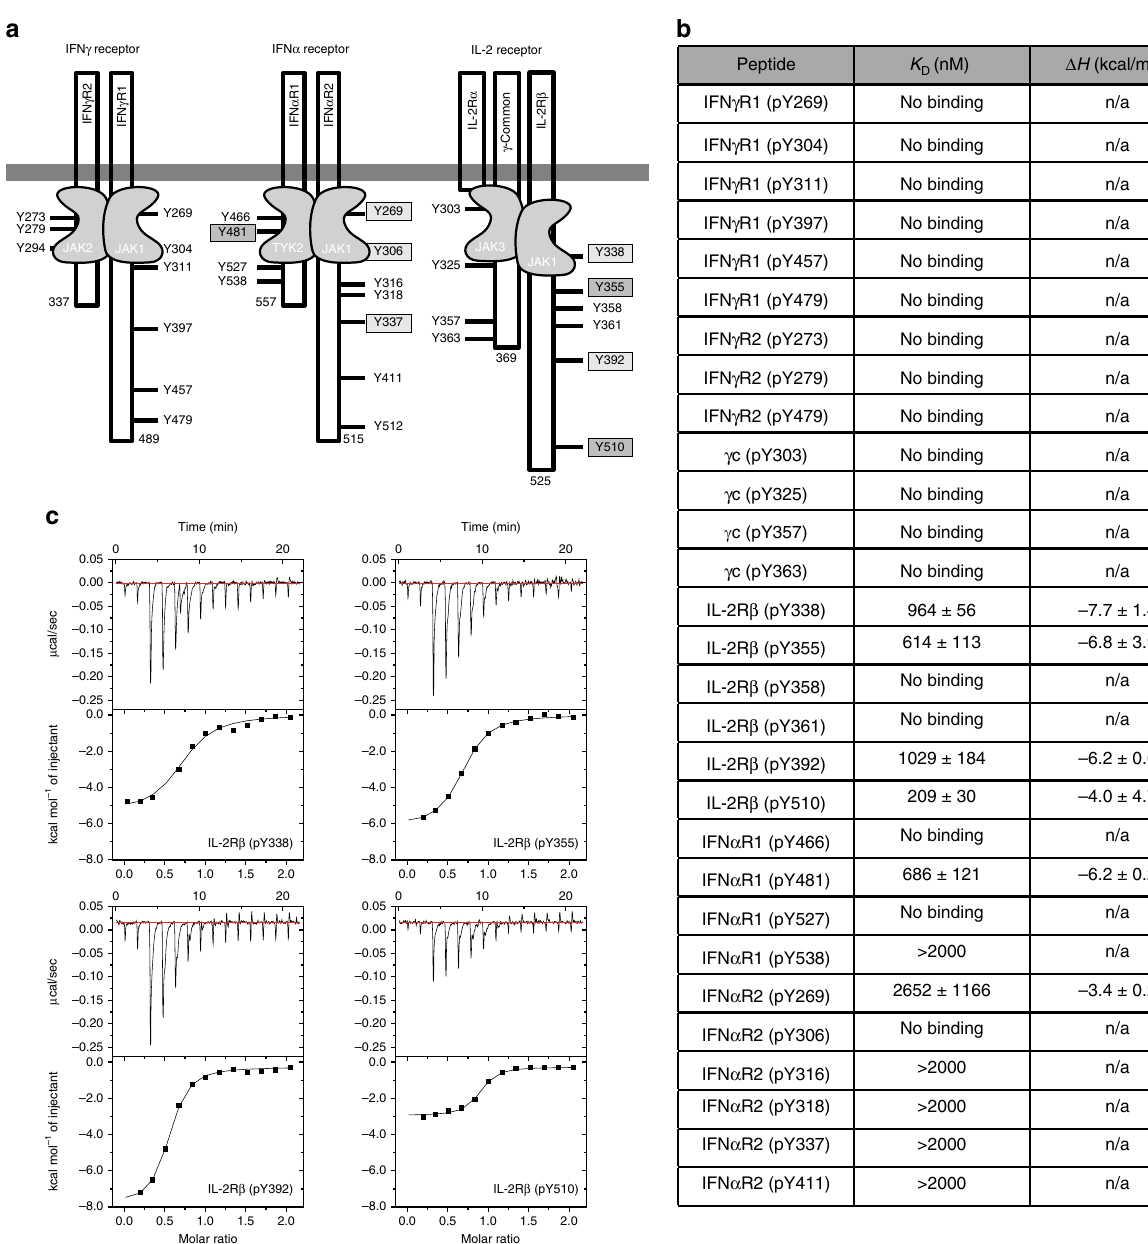
Fig. 5 SOCS1 does not bind to any pTyr sites on the interferon gamma receptor. a Schematic diagrams of the IFN- α , ɣ and IL-2 receptors. All intracellular tyrosines are shown. b Table showing the binding af fi nities of human SOCS1 for each IFN- ɣ and IL-2 receptor phosphopeptide. Errors represent standard deviation from three independent experiments. c Representative ITC curves are shown for the four IL-2R phosphopeptides that bind to SOCS1 with sub- micromolar af fi interaction could not occur. Therefore, we obtained syn- thetic peptides representing the activation loop of all four JAKs to investigate whether such an interaction is possible. As shown in Fig. 6, SOCS1 bound tightly (<1 µM af fi nity) to activation loops phosphopeptides of all four JAK family members. As the inter- action with the JAK1 activation loop was higher than any receptor peptides, we generated a series of alanine point mutants of this peptide to attempt to derive a consensus sequence (Sup- plementary Table 2). Although no de fi nitive consensus motif could be identi fi ed, analysis of these data in addition to the binding data from the receptor peptides suggest that hydrophobic residues at the + 1 and + 3 positions are preferred (pY – ϕ – X – ϕ ).